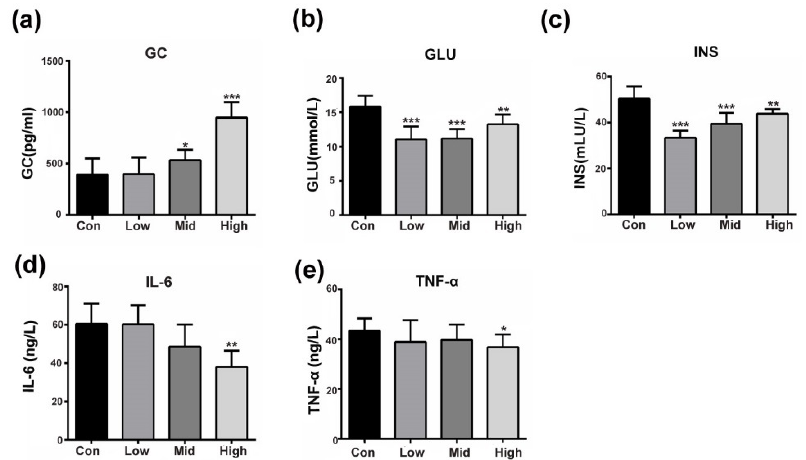
Figure 1. GA affects insulin-responsive pathway in the whole body. ( a – e ) Fasting plasma glucocorticoid (GC), insulin (INS), glucose (GLU), IL-6 and TNF- α concentration after GA administration. The mice were treated with saline 0.5 mL/day (control) or GA (High, 100 mg/kg; Mid, 50 mg/kg, Low, 25 mg/kg). The assay was performed as the mean ± S.D. ( n = 10). * p < 0.05, ** p < 0.01, *** p < 0.001 compared to the control.